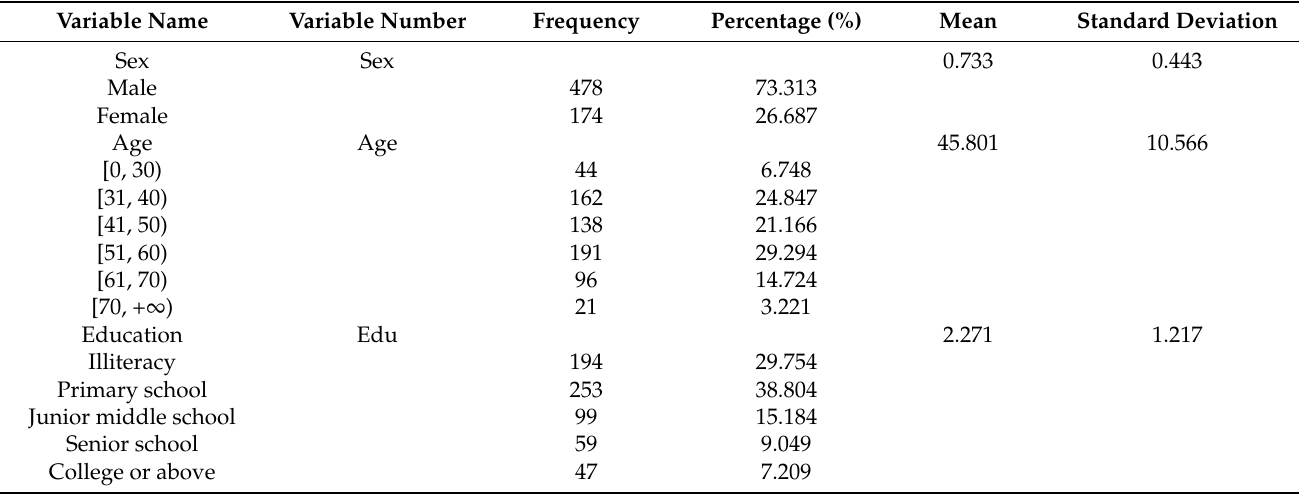
Table 2. Description of the basic characteristics of the sample farmers ( n =